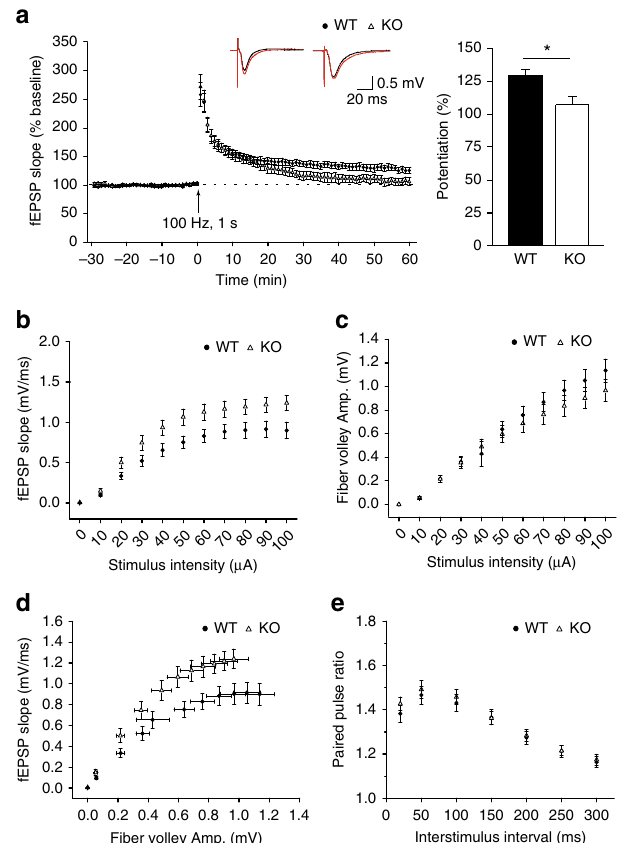
Fig. 2 Phf8 null mice display compromised long-term potentiation and enhanced basal synaptic transmission. a Shown are the slopes of fi eld excitatory postsynaptic potentials (fEPSP) before and after tetanic stimulation (a train of 100Hz stimulation for 1 s) recorded from hippocampal slices (WT, n = 7 slices from fi ve mice; KO, n = 8 slices from six mice). Sample traces show averaged baseline responses (black) and responses during the last 10min of recording (red) in WT and Phf8 KO animals. The ratio between fEPSP during the last 10min recording and baseline is analyzed to evaluate the potentiation (right panel, 129.3 ± 5.1% in WT vs. 107.4 ± 6.0% in KO; unpaired two-tailed t -test, p = 0.0164). b Plot of input – output relationship (I – O curve) at Schaffer collateral-CA1 synapses in the hippocampal slices(one-way ANOVA, F (1, 207) = 14.401, p = 0.0002). The I – O curve obtained from PHF8-mutant mice is left-shifted compared with control (WT, n = 10 slices from fi ve mice; KO, n = 9 slices from fi ve mice). c Presynaptic fi ber volley amplitude measured at increasing stimulus intensities (10 – 100 μ A, one-way ANOVA, F (1, 207) = 1.000, p = 0.3185). d Scatter plot of fEPSP slope vs. diverse fi ber volley amplitudes. The horizontal and vertical bars indicate the standard errors for fi ber volley amplitudes and slope of the fEPSP, respectively. e Paired-pulse ratio measured at different inter-stimulus intervals reveals no differences in presynaptic release of transmitter between WT and Phf8 KO groups ( n = 10 slices from fi ve mice for each genotype; one-way ANOVA, F (1,138) = 0.444, p = 0.5063). All data are shown as mean ± s.e.m. * p <